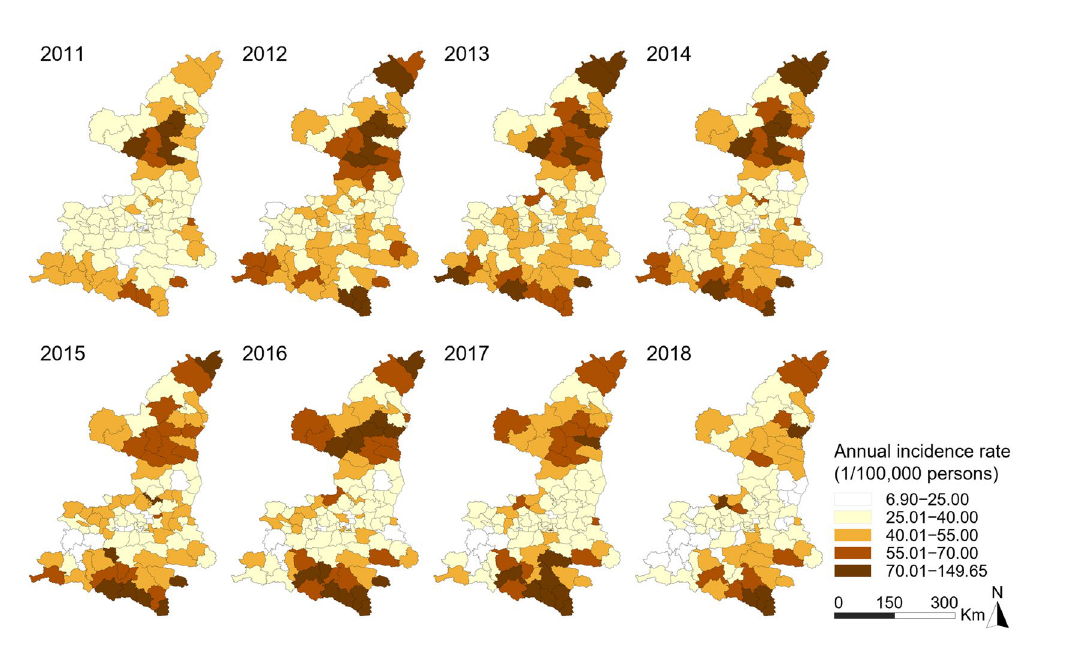
Figure 4. Annual notified incidence rate of